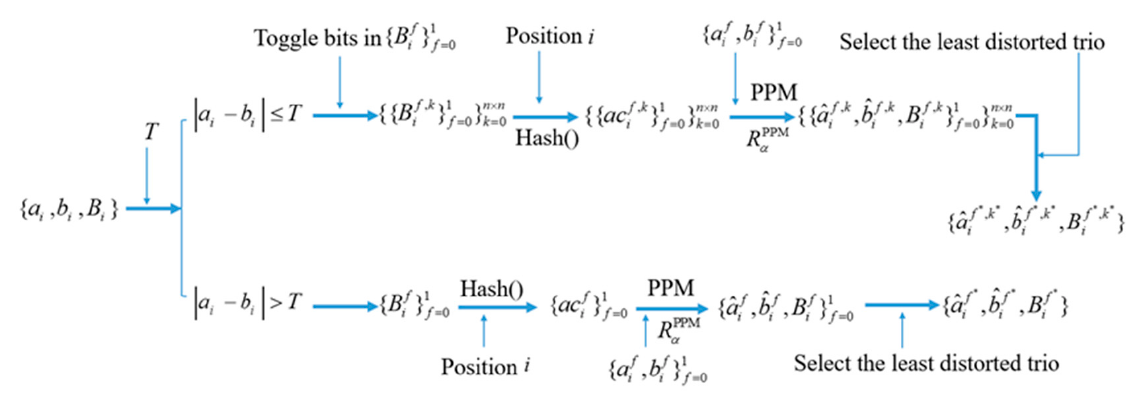
Figure 3. The embedding procedures of the proposed method.